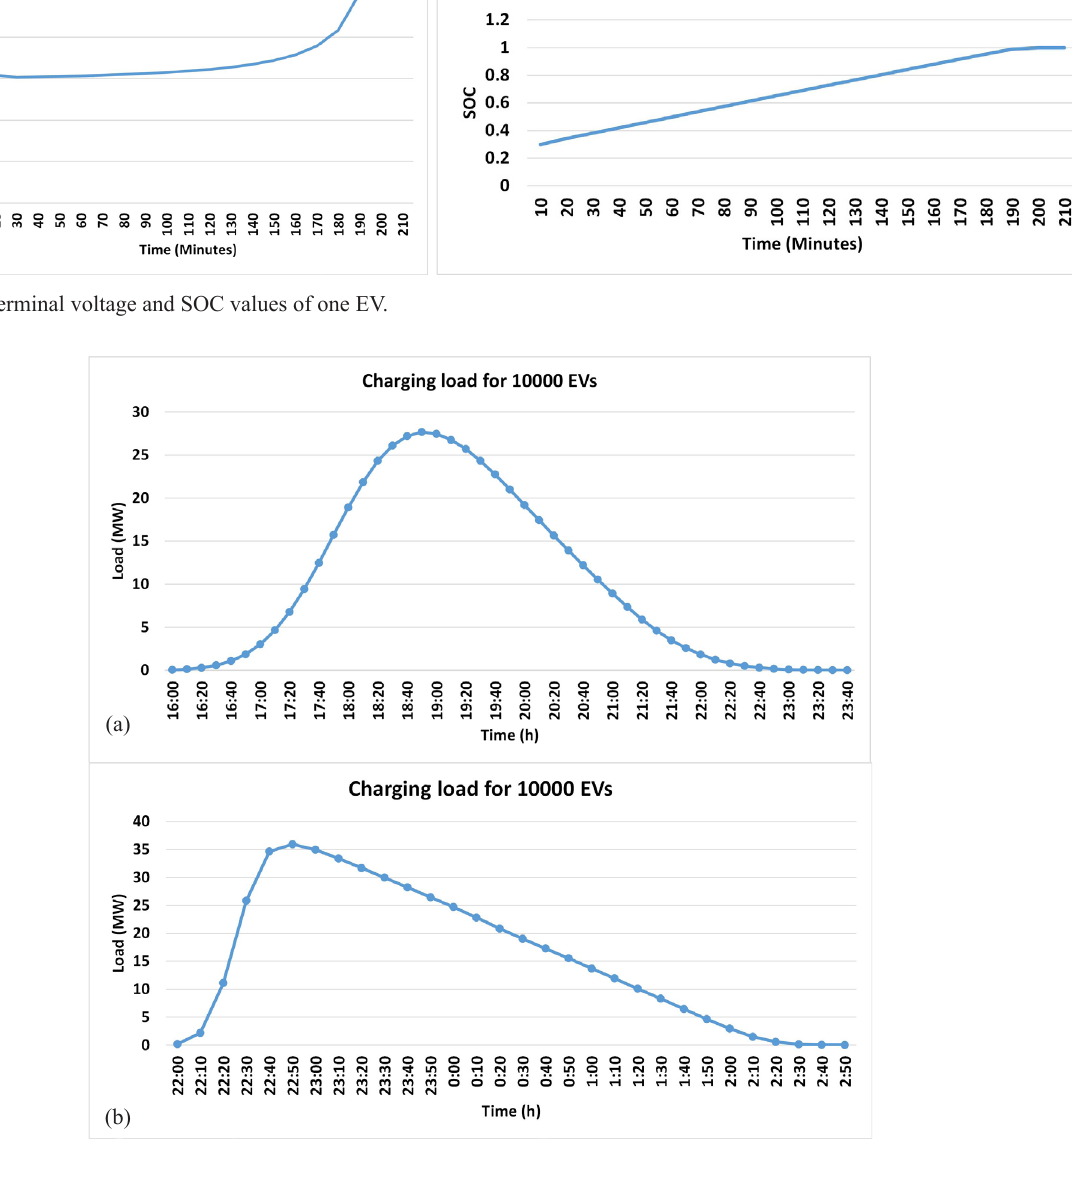
Figure 5: Charging load of 10,000 EVs (a) Dump charging (b)